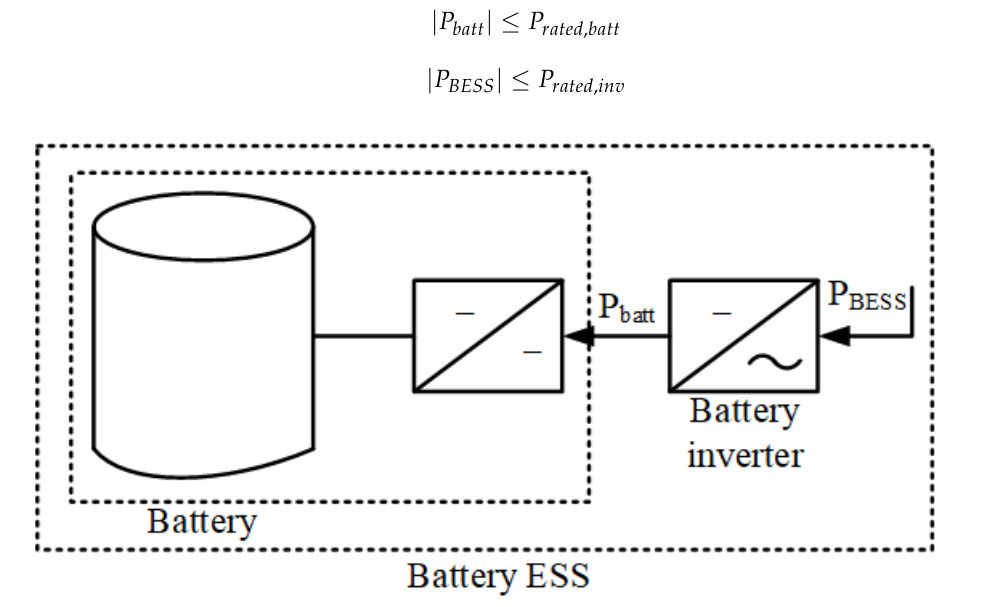
Figure 4. Illustration of the battery storage